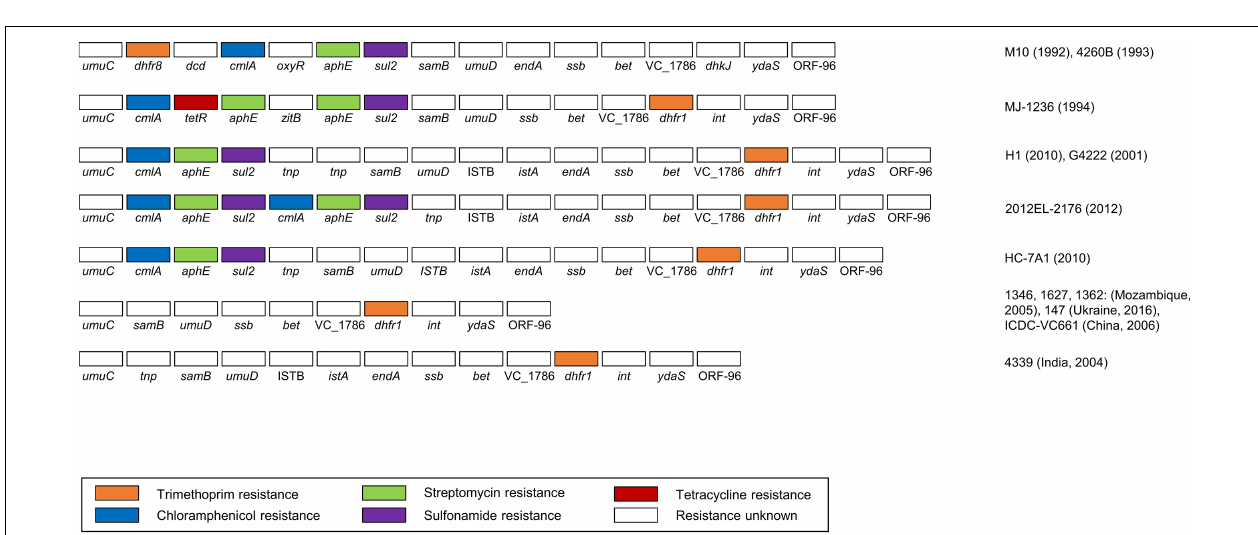
FIGURE 5 | The gene contents and structures of eight types of SXT elements predicted to be resistant to several antibiotics. The drug-resistance genes are highlighted in the following colors: orange (trimethoprim), blue (chloramphenicol), green (streptomycin), purple (sulfonamide), and red (tetracycline). The representative strains are indicated on the